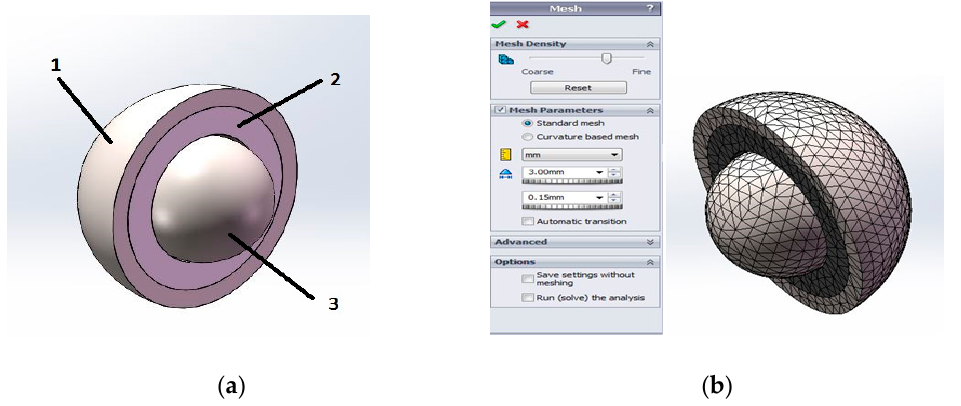
Figure 3. FEA model of the hip replacement: ( a ) hip components: 1—acetabular cup (TiAl6V4); 2—acetabular liner (PA 2200); 3—femoral head (TiAl6V4); ( b ) mesh of the FEA model.